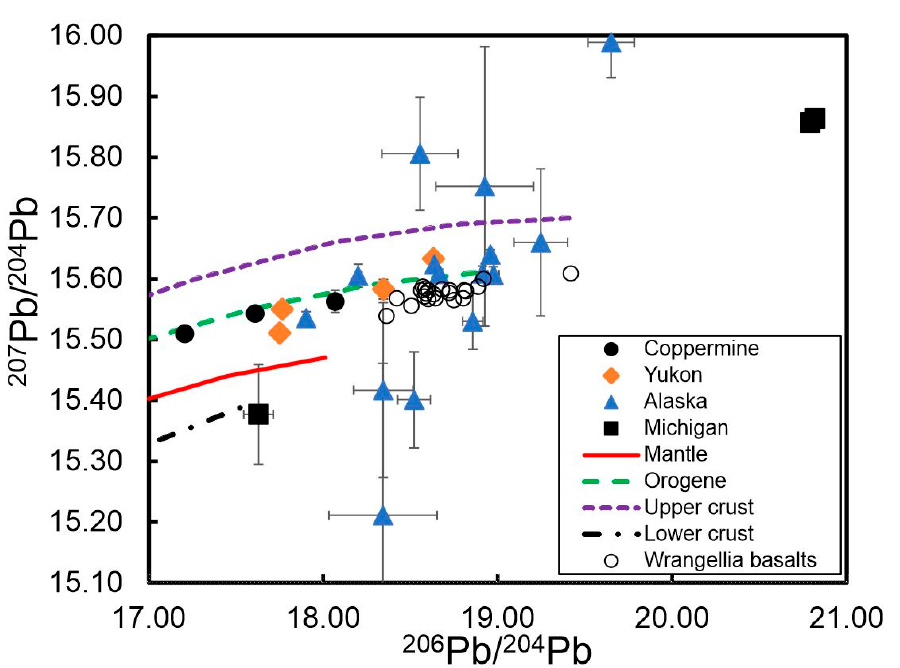
Figure 2. Plot of 207 Pb/ 204 Pb versus 206 Pb/ 204 Pb ratios for native Cu samples investigated here. Pb isotope data for mantle, orogene, and lower and upper crust evolution curves are taken from [28], whereas Pb isotope compositions for Wrangellia basalts are from [29]. Error bars represent associated 2s level uncertainty and are not shown if these are within the size of the symbol.